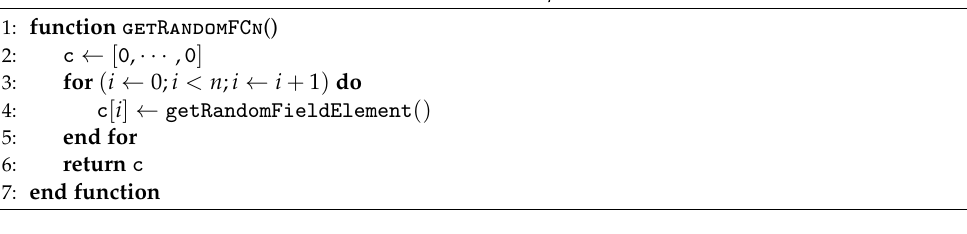
Algorithm 18 Computes a random element from F θ σ